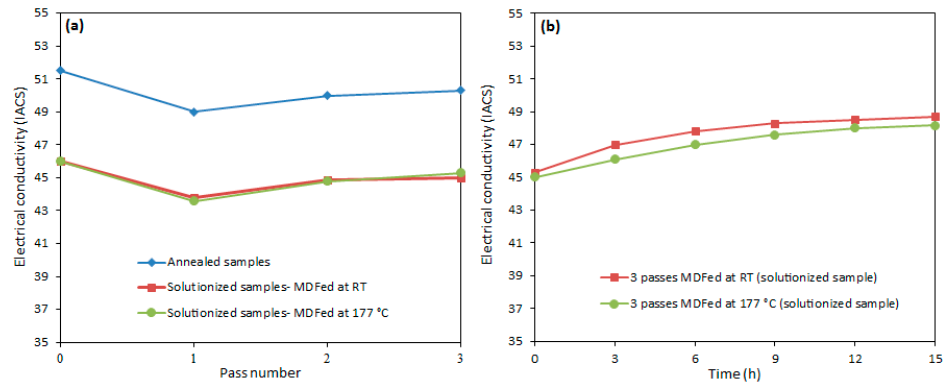
Figure 10. Electrical conductivity changes of the annealed and solution-treated samples of AA-6063 with respect to: ( a ) the number of MDF passes and ( b ) aging time. Table 2. Electrical conductivity measurement results (annealed and solution ‐ treated samples of AA ‐ 6063).